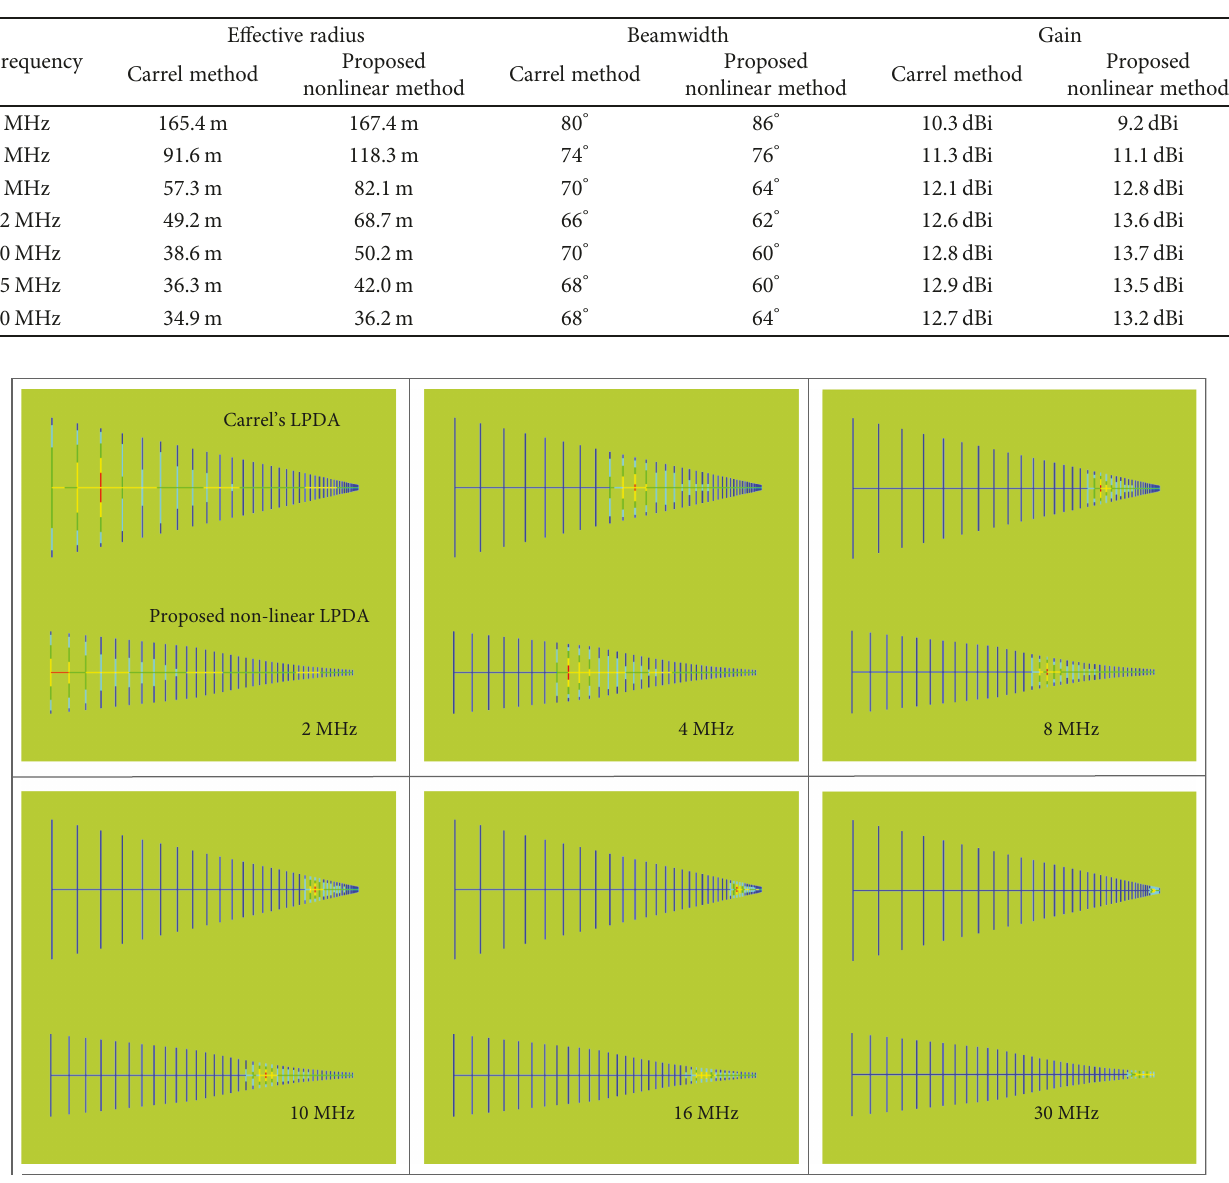
Table 3: Comparison with the Carrel antenna and proposed antenna.